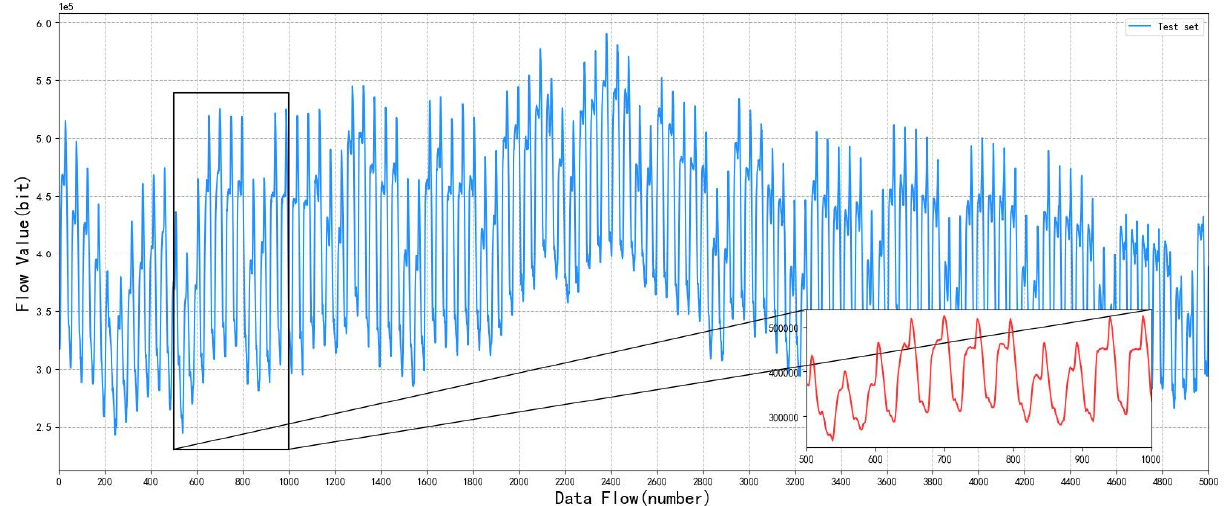
Figure 6. Test set of satellite network traffic data.